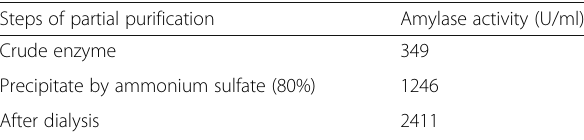
Table 2 Partial Purification of amylase enzyme produced by Aspergillus terreus